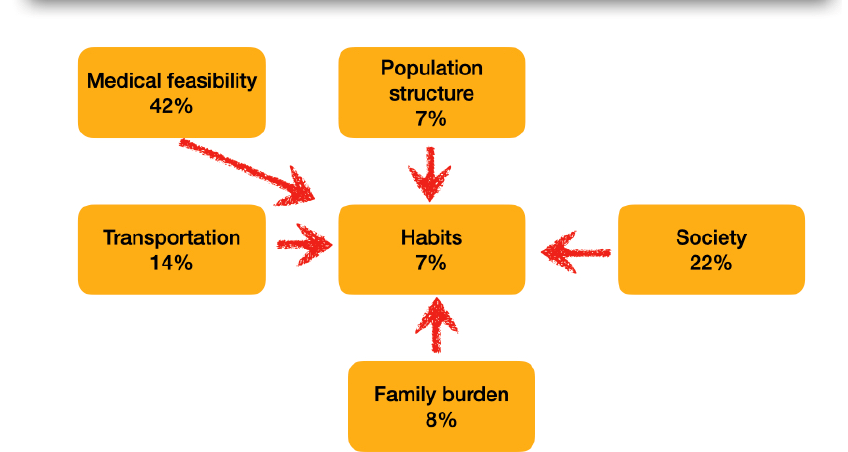
Figure 2. Key factors supporting the new model.